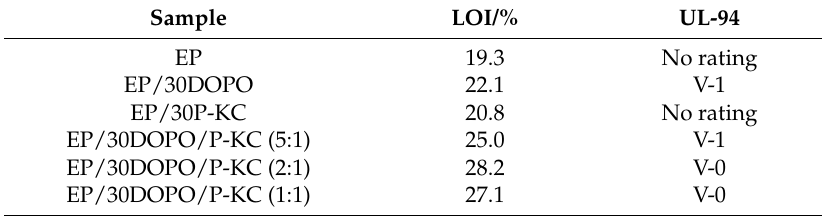
Table 4. Limited oxygen index (LOI) and UL-94 test results of different